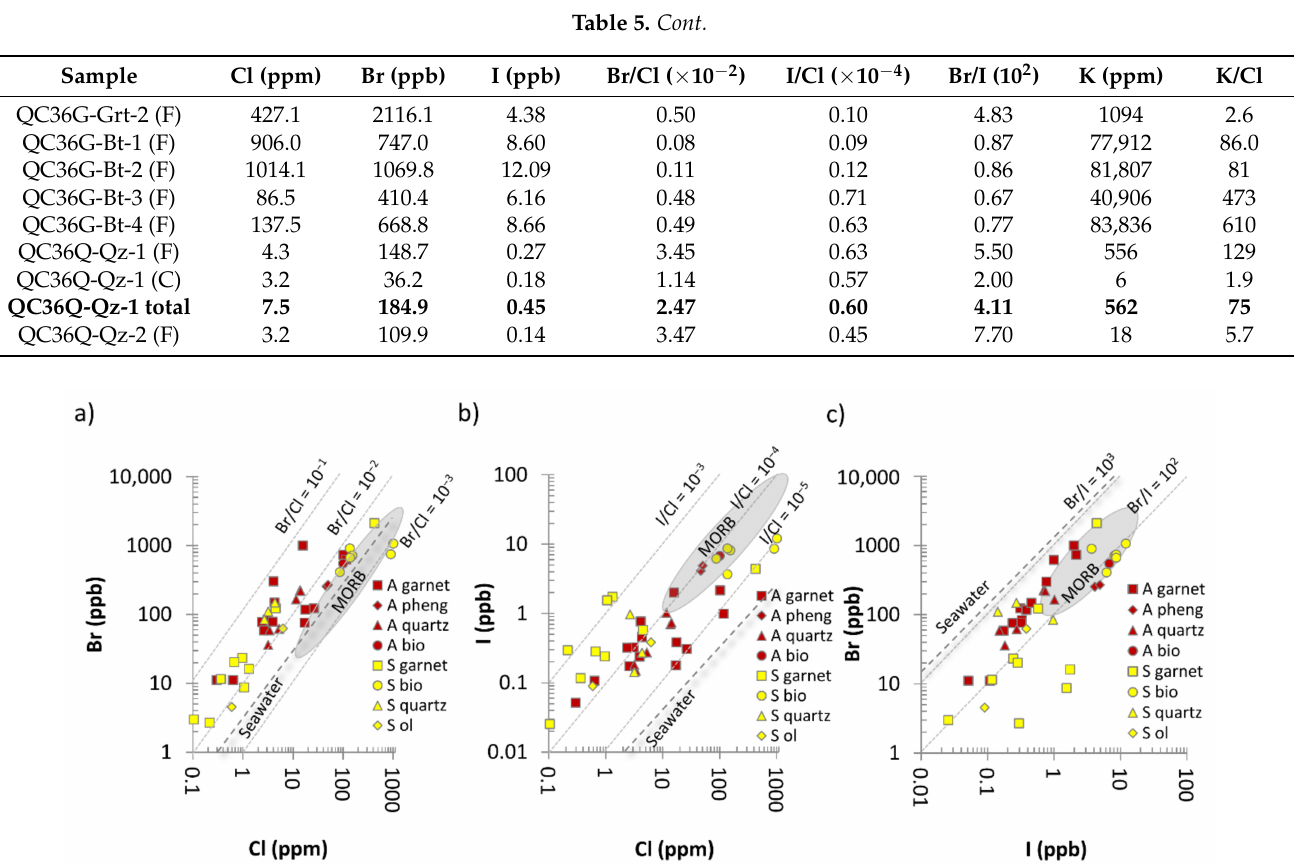
Figure 7. The Br/Cl ( a ), I/Cl ( b ) and Br/I ( c ) ratios of Årsheimneset and Svartberget separates, along with MORB, seawater and constant halogen ratio values. MORB fields from [8,12,88]. See Figure S1 in the Supplementary Materials for an extension to this figure that includes several further